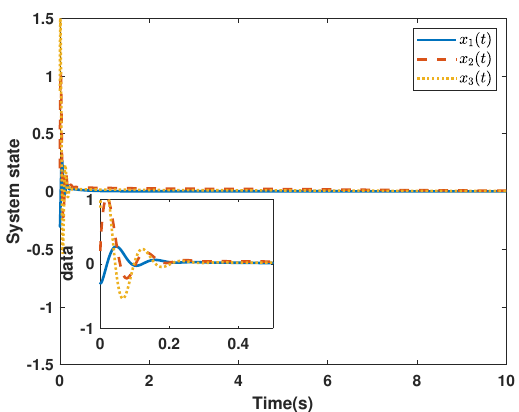
Figure 8. State trajectories of System (1) under the adaptive SMC law.